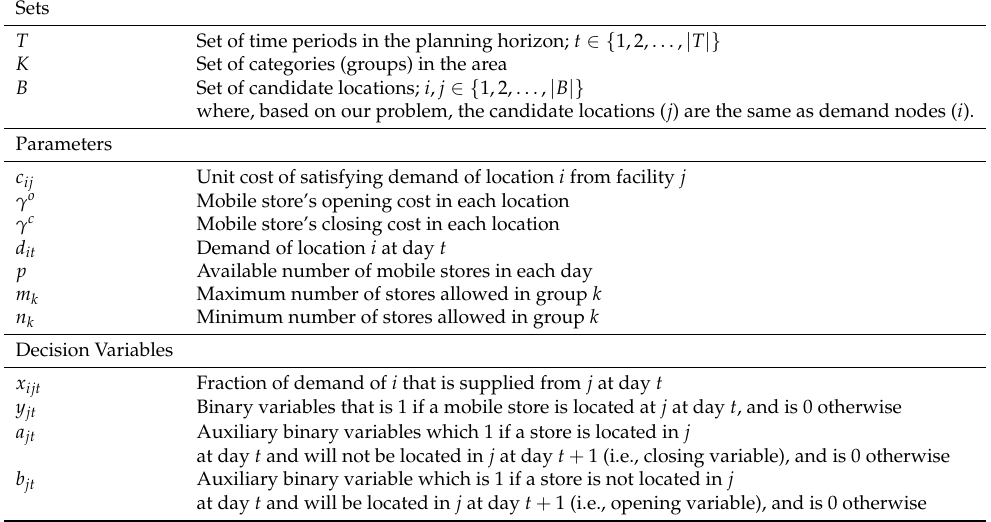
Table 1. Notations used for mathematical modeling of